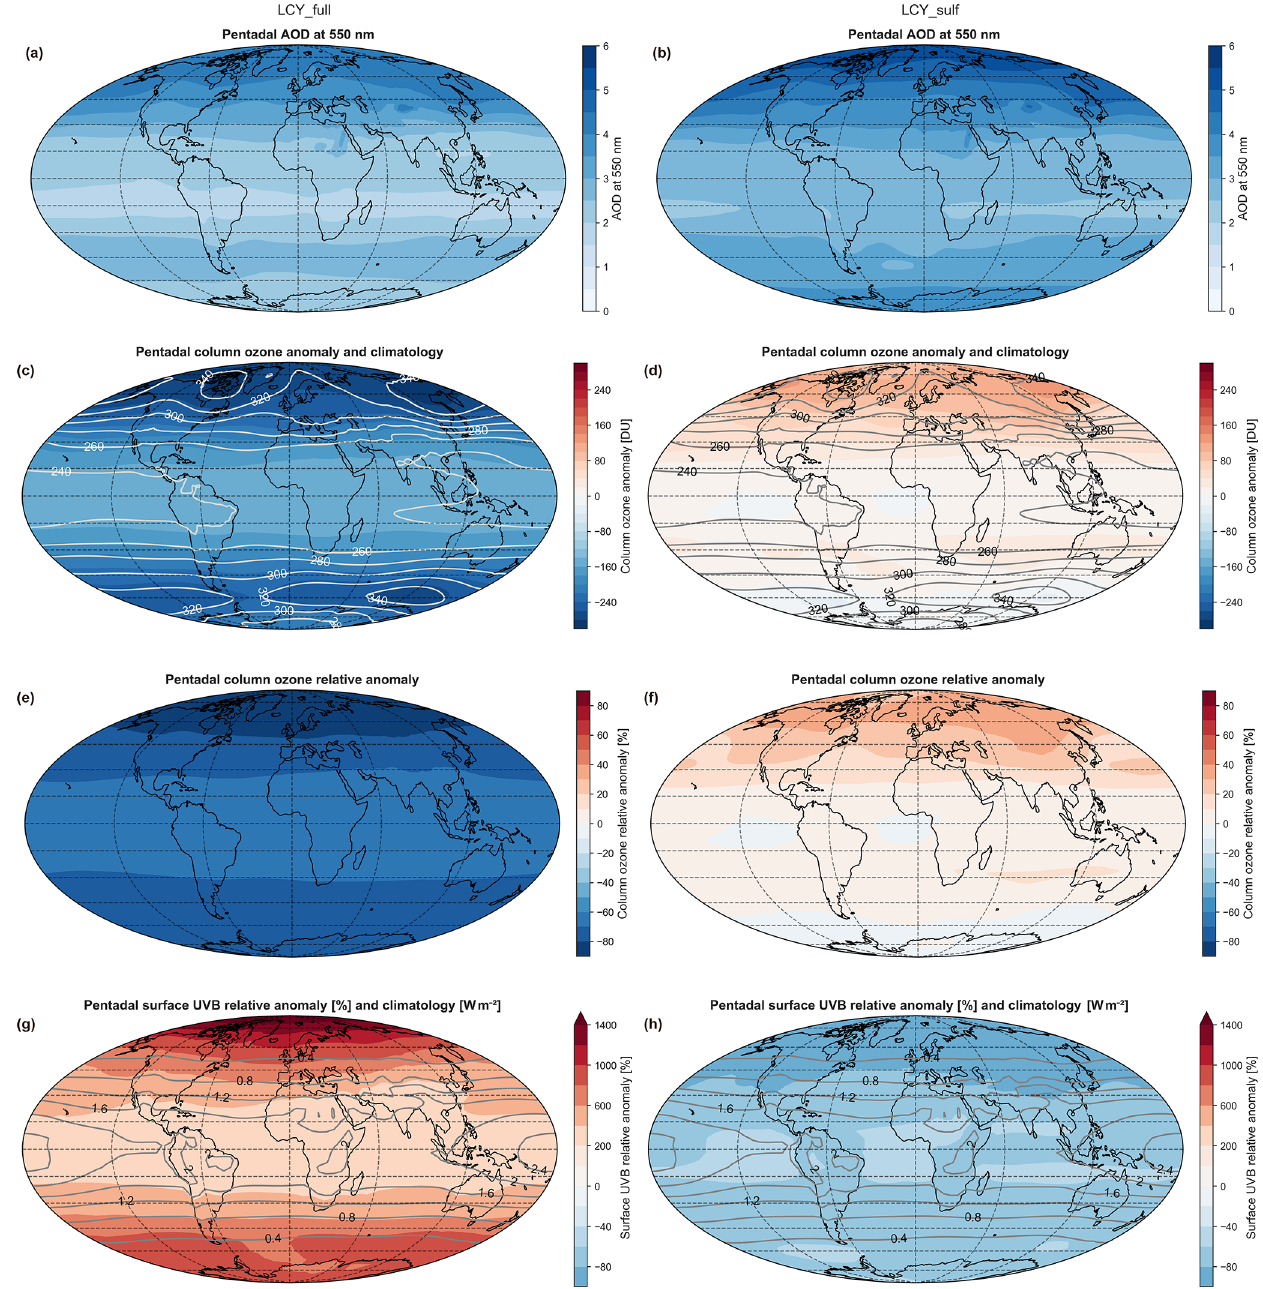
Figure 4. Maps of post-eruption 5-year (pentadal) means: AOD (a, b) , ozone anomaly and climatology (c, d) , ozone change (e, f) and surface UVB weighted for DNA damage change and climatology (g, h) for left side LCY_full (a, c, e, g) and right side LCY_sulf (b, d, f, h)